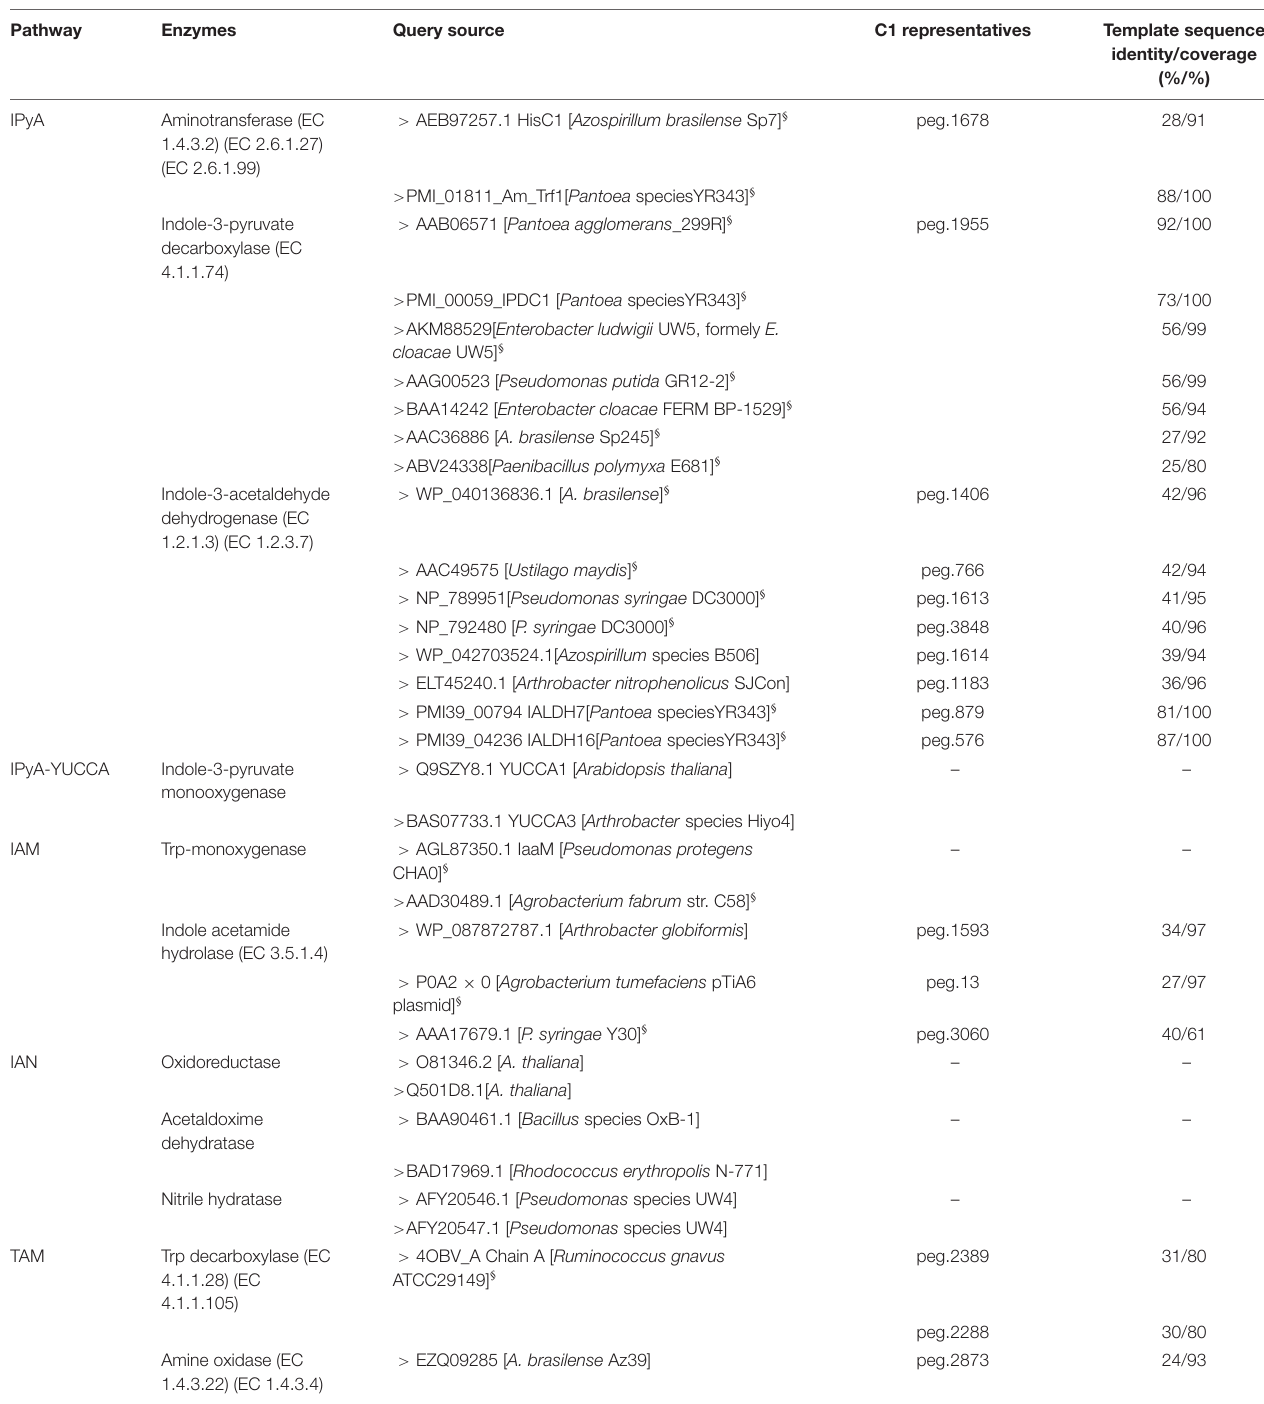
TABLE 1 | Identification of protein encoding genes (peg) and enzymes involved in IAA biosynthesis in P. agglomerans strain C1 based on a systematic computational approach. Pathway